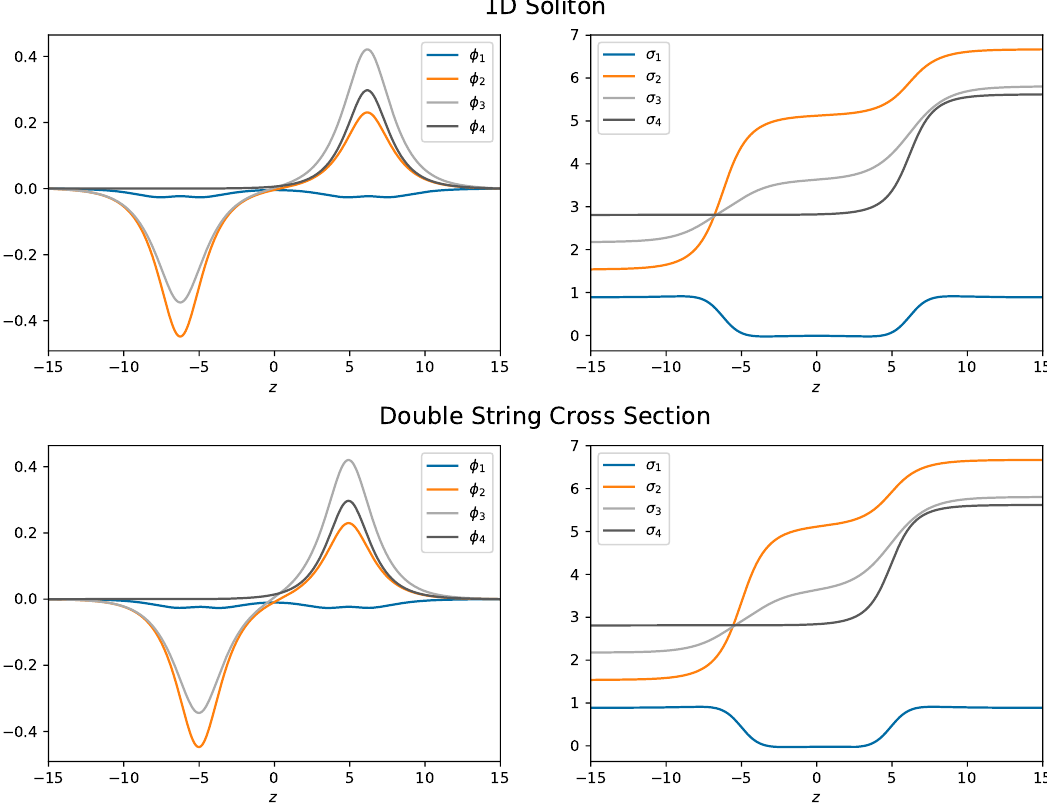
Figure 19. One-dimensional DW versus the y = 0 cross section of a double string for N = 5 and N -ality k = 2 . The top row shows the field of the 1D DW, which was produced by relaxing a configuration consisting of the sum of two 1-walls, as described in section 7.2. The bottom row shows a y = 0 cross section similar to that depicted in figure 6, although here the σ field has been translated by 2 π w 2 in the region z > 0 such that it is